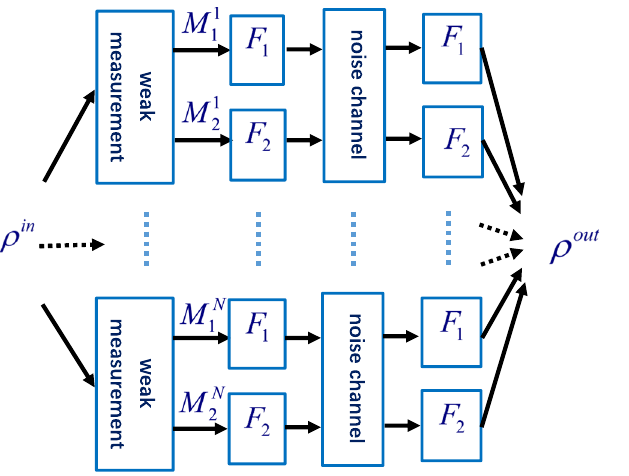
Figure 1. WMPPF scheme for N -qubit